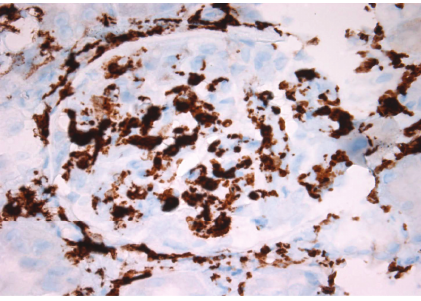
Figure 3: A large number of glomerular cells stain positively for the CD163 monocyte marker (immunohistochemistry).